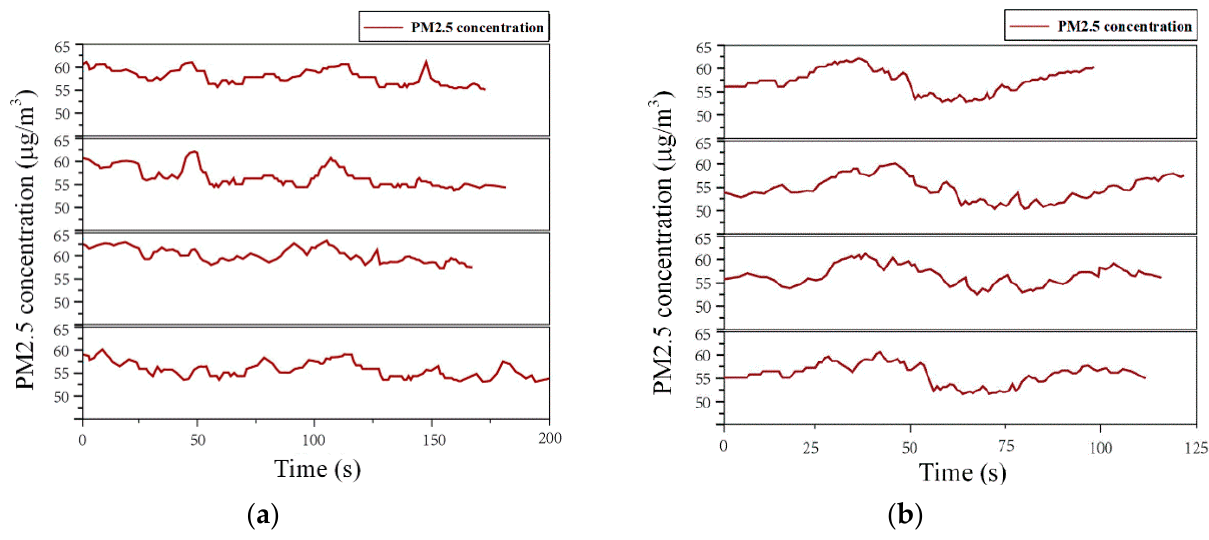
Figure 24. PM2.5 concentration-time curves for pedestrians during boarding and alighting: ( a ) Boarding; ( b ) Alighting.